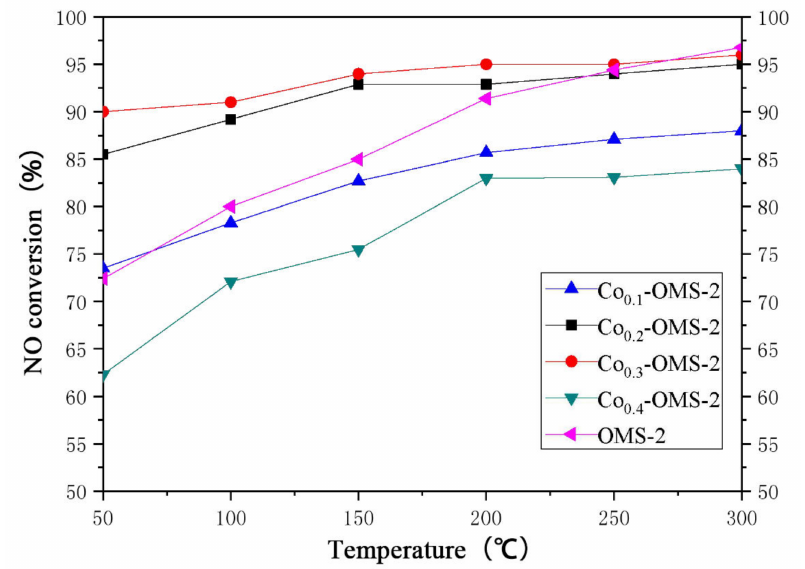
Figure 10. NO conversion curves of OMS-2 prepared by Co doping method.